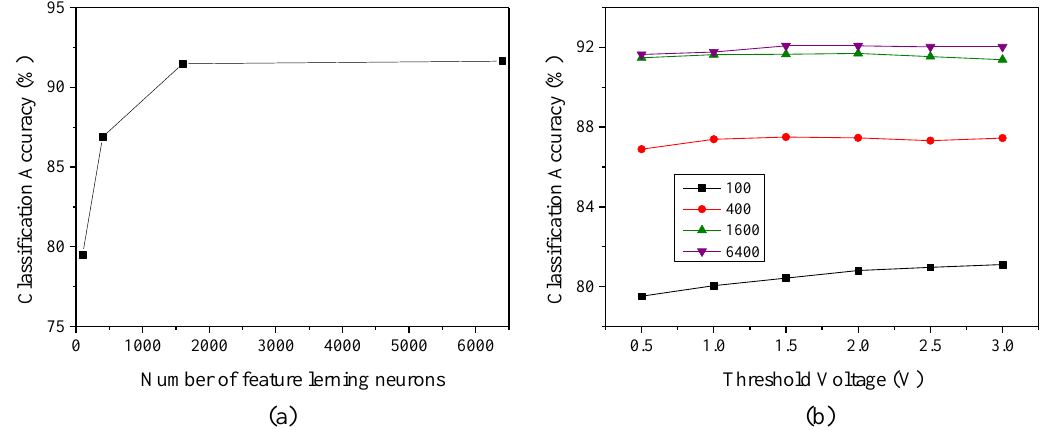
Figure 5. ( a ) Impact of the number of feature learning neurons on classification accuracy, ( b ) impact of the threshold voltage for testing on classification accuracy.